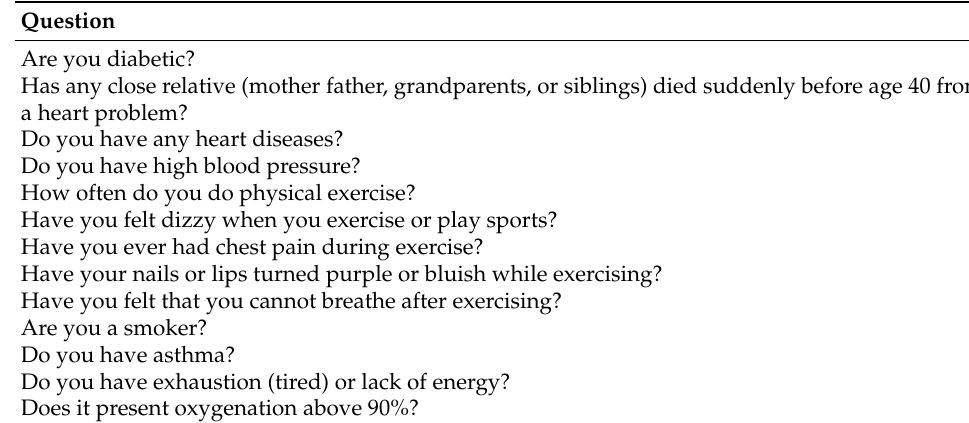
Table 1. Core questions on cardiovascular and respiratory conditions.